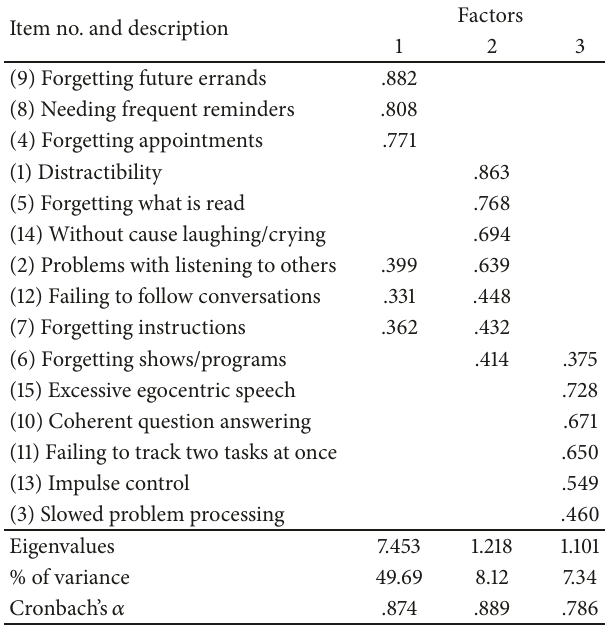
Table 4: Rotated solution and factor loadings of MSNQ-P